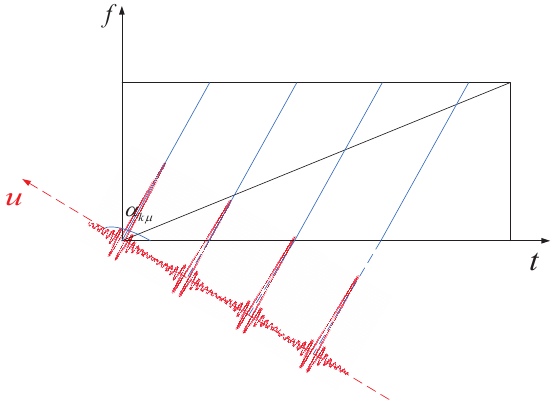
Figure 1. Schematic diagram of FRFT of SMSP